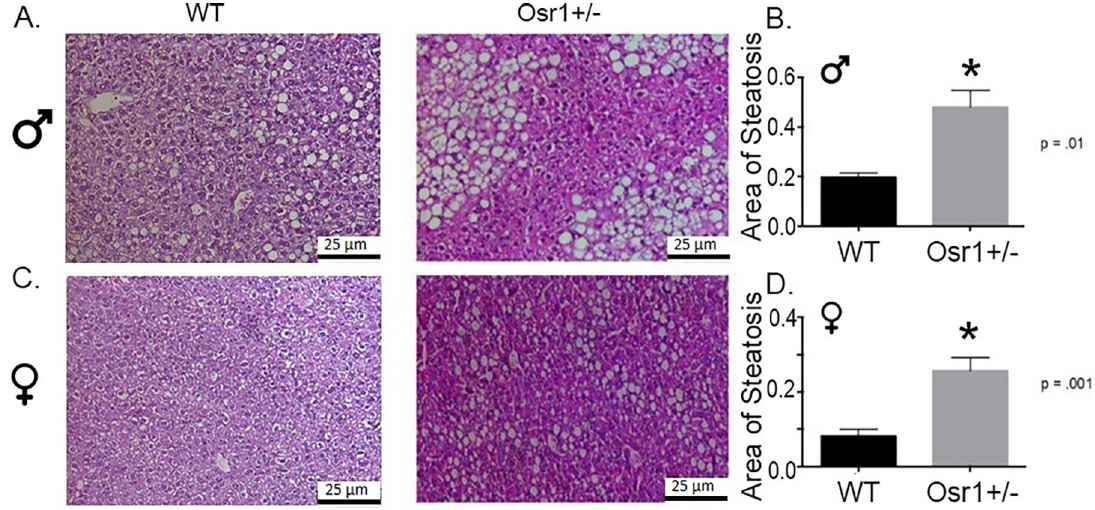
Fig 2. Osr1 heterozygous mice exhibit more severe hepatic steatosis induced by the HF diet. (A). HE staining of male liver tissue. (B). Osr1 heterozygous male mice had significantly larger area of steatosis. (C). HE staining of female liver tissue. (D). Osr1 heterozygous female mice had significantly larger area of steatosis. Scale = 25 μ m. Data is presented as Mean ± SD, N = 5; � p <